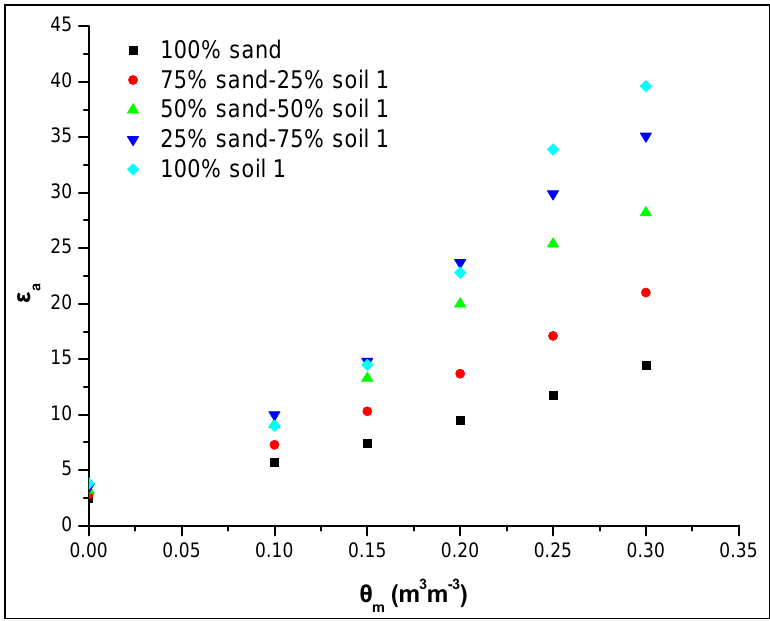
Figure 7. Relationship between the apparent dielectric permittivity ε a and the actual soil water content θ m for five different ratios of the sand ‐ soil mixture studied using the WET sensor.